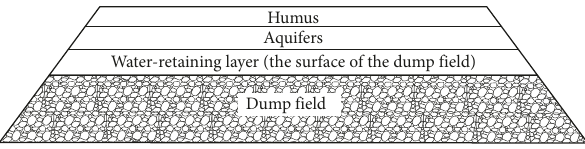
Figure 1: Reclaimed soil layer distribution in dumping